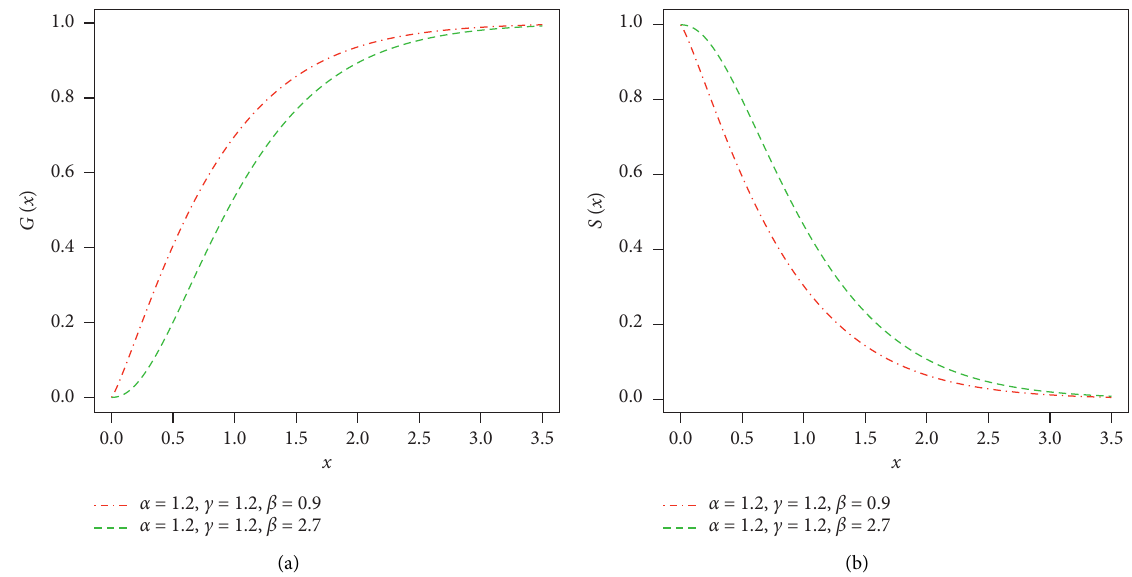
Figure 2: Graphical sketching of the HTBPT–Weibull cdf and sf plots for selected parameter values.